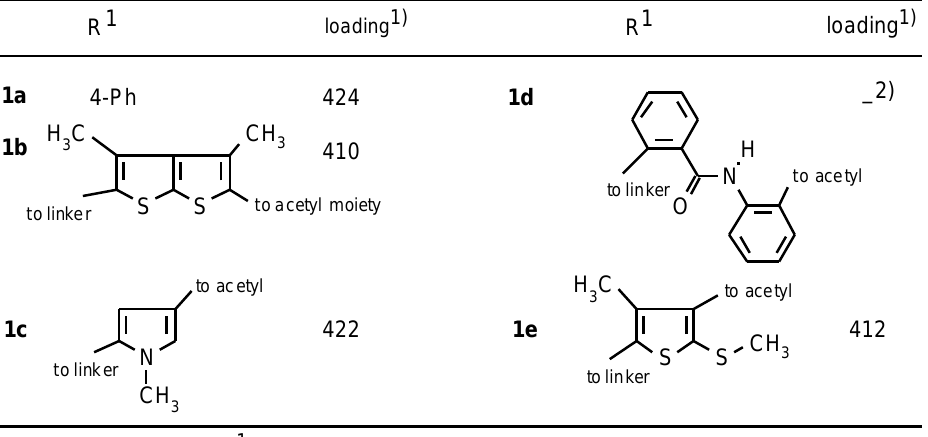
Table 1. Building